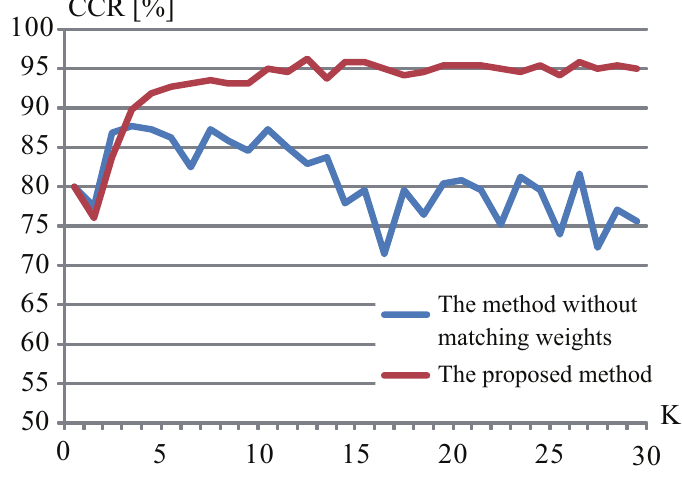
Figure 7. Correct classification rates by the proposed method and the method without matching weights.